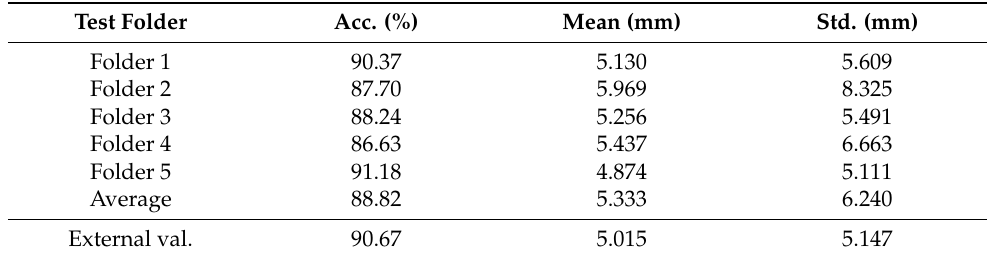
Table 1. The performance in ETT–Carina distance